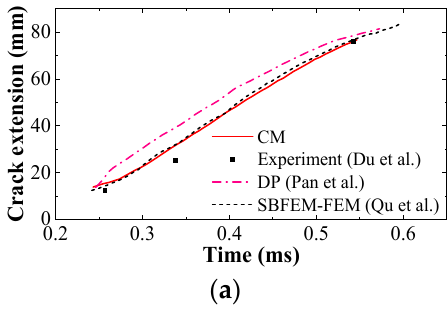
Figure 4. Comparison between numerical simulation and existing research results [38–40]. ( a ) Crack extension history; ( b ) load-vertical displacement curves at the loading point.